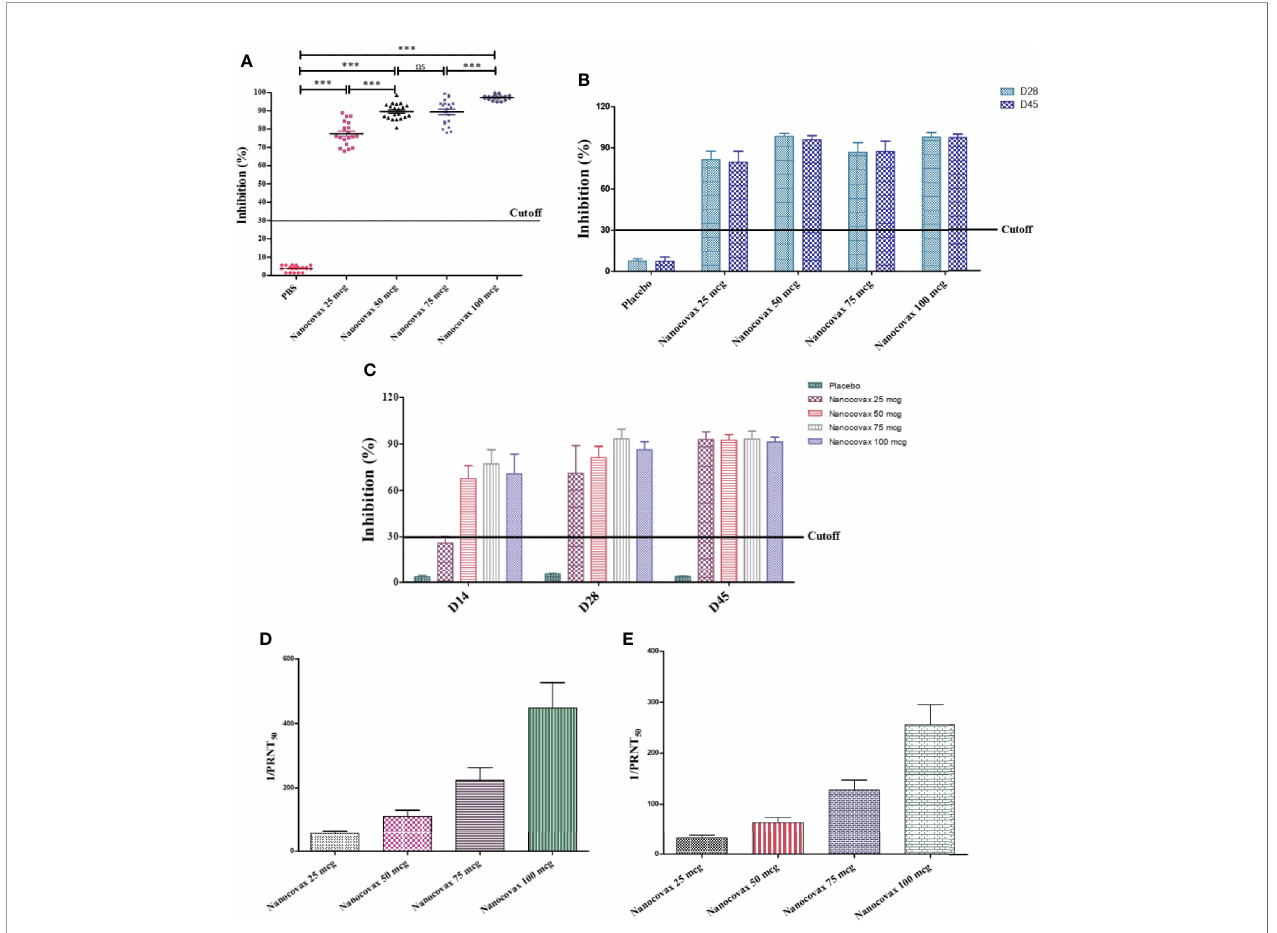
FIGURE 4 | SARS-CoV-2-neutralizing antibodies. BALB/c mice were intramuscularly injected twice 7 days apart. Blood was collected on day 14 to determine SARS-CoV-2-neutralizing antibodies by in vitro surrogate virus neutralization assay (A) . Syrian hamsters were intramuscularly injected twice 7 days apart. Blood was collected on days 28 and 45 to determine SARS-CoV-2-neutralizing antibodies by in vitro surrogate virus neutralization assay (B) . Northern pig-tailed macaques were intramuscularly injected twice 7 days apart. Blood was collected on days 14, 28, and 45 to determine SARS-CoV-2-neutralizing antibodies by in vitro surrogate virus neutralization assay (C) . The SARS-CoV-2 neutralizing antibodies in the BALB/c (D) and hamster (E) models were also measured by PRNT 50 assay. The data represent the mean ± SD, and p -values were determined by one-way ANOVA with the Newman – Keuls multiple comparison test and two-way ANOVA analysis with Bonferroni post-hoc tests (*** p < 0.001; ns, not signi fi